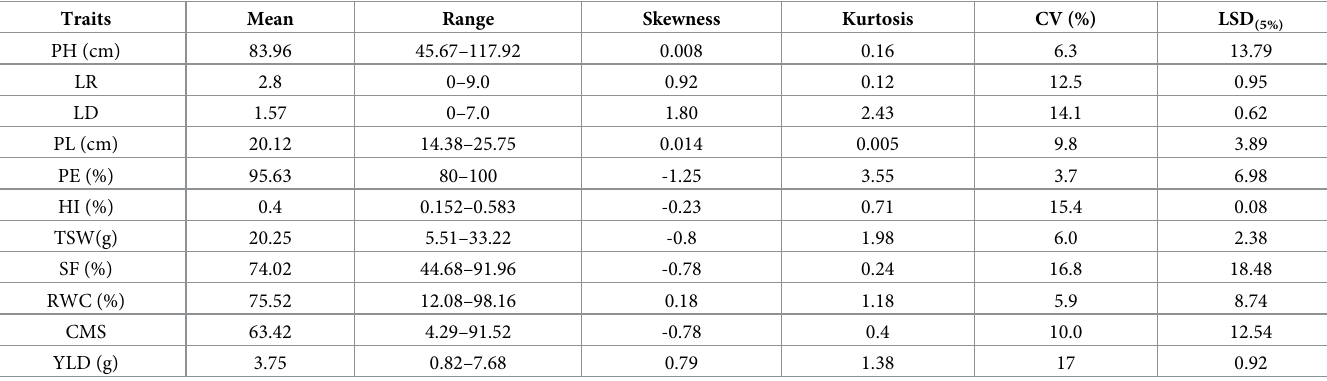
Table 4. Mean statistical parameters estimated from RILs for eleven morpho-physiological traits under reproductive stage drought stress. Traits